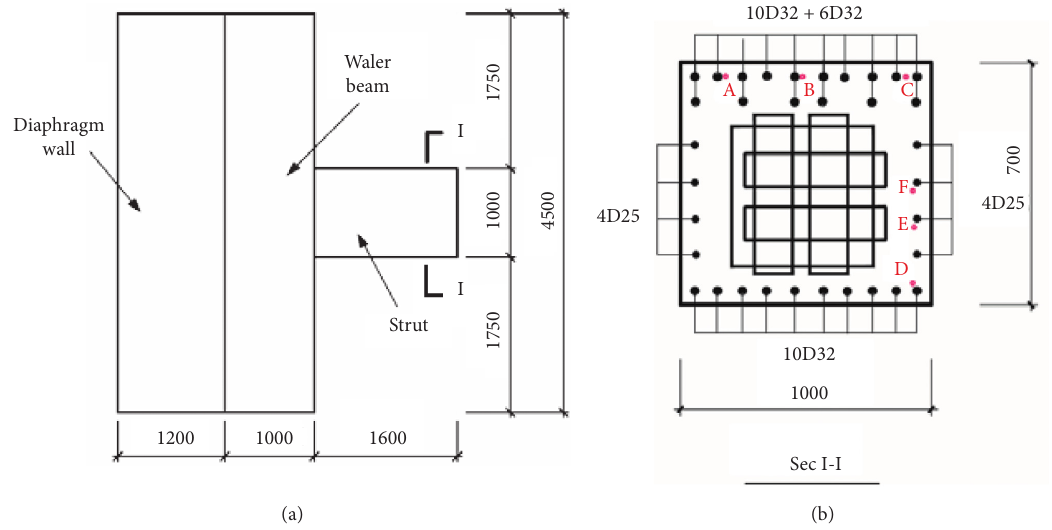
Figure 3: Top view of the test structure and optic fiber arrangement (unit: mm).